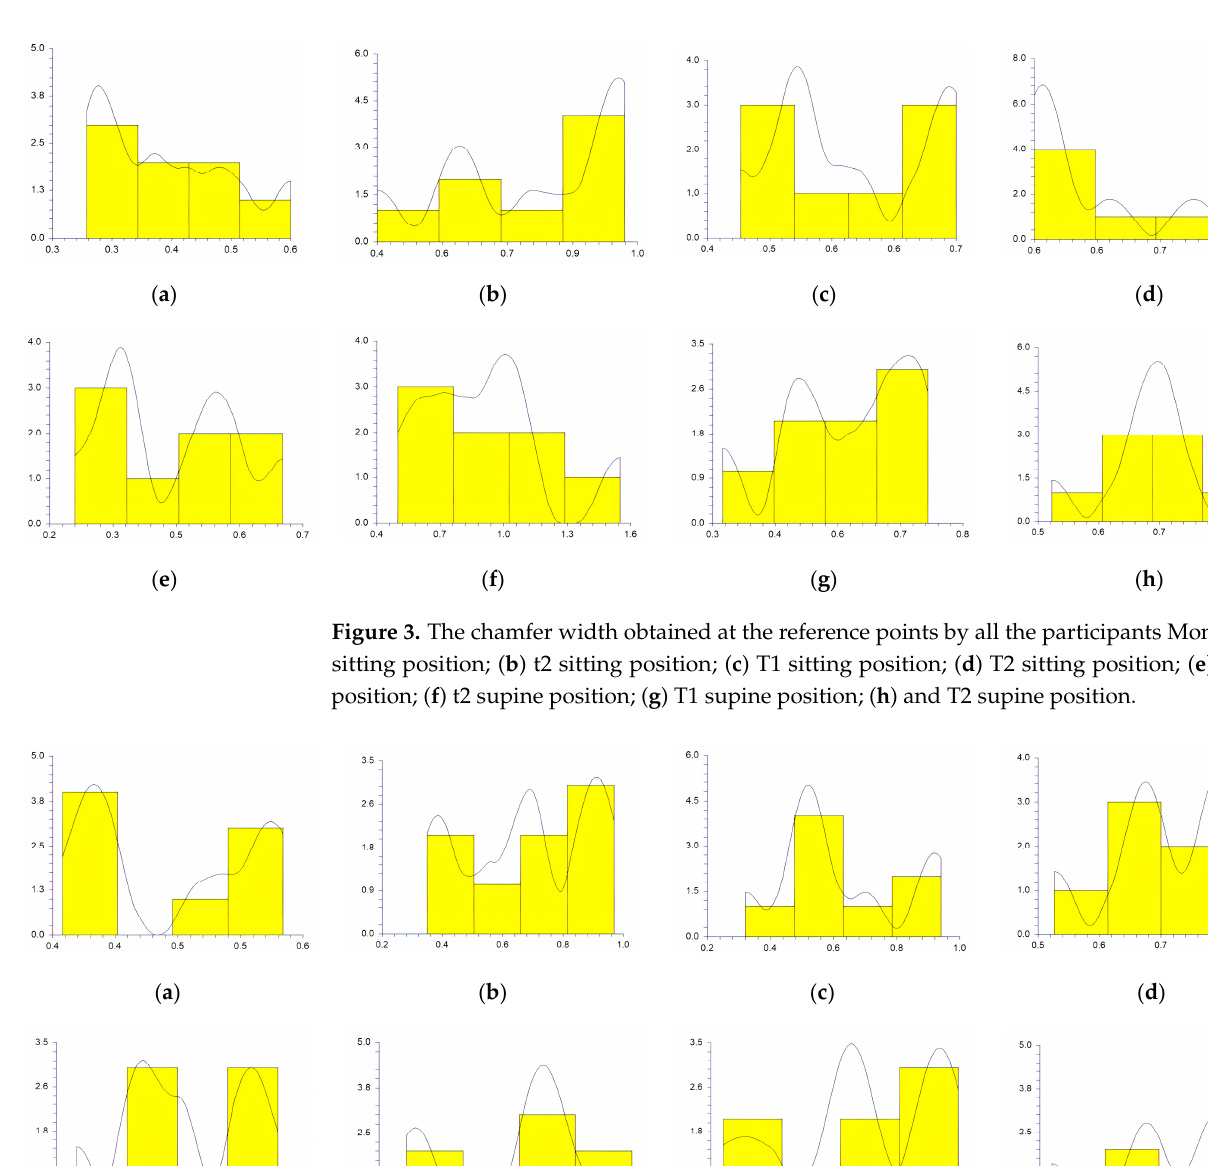
( h ) Figure 5. The chamfer width obtained at the reference points by all the participants Wednesday: ( a ) t1 sitting position; ( b ) t2 sitting position; ( c ) T1 sitting position; ( d ) T2 sitting position; ( e ) t1 supine position; ( f ) t2 supine position; ( g ) T1 supine position; ( h ) and T2 supine position.